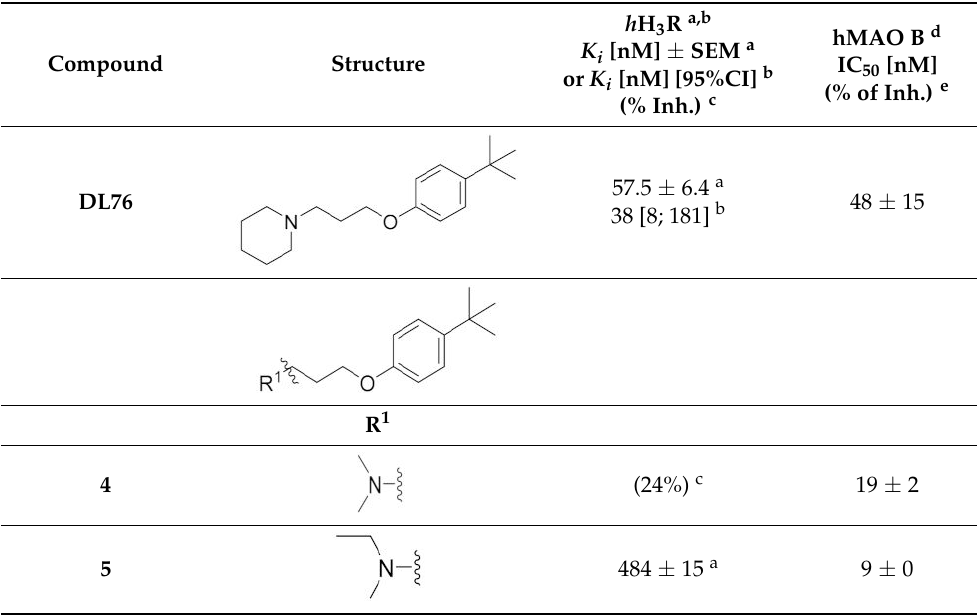
Figure 2. General structural modifications of DL76 . Table 1. In vitro affinities for human histamine H 3 receptor and human MAO B inhibitory activities of the target compounds 4 – 17